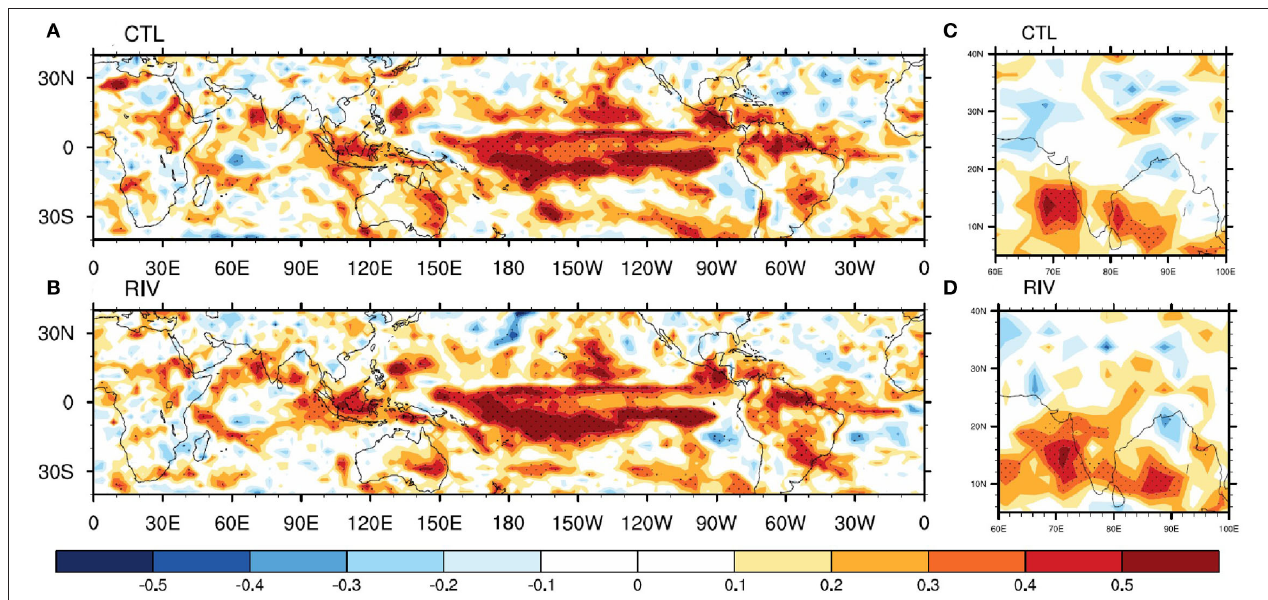
FIGURE 11 | June-September (JJAS) mean anomaly correlation coefficient between GPCP and model simulations for (A) CTL run and (B) RIV run. (C) and (D) same as (A) and (B) but zoomed over India. Correlations significant at 90% confidence level are